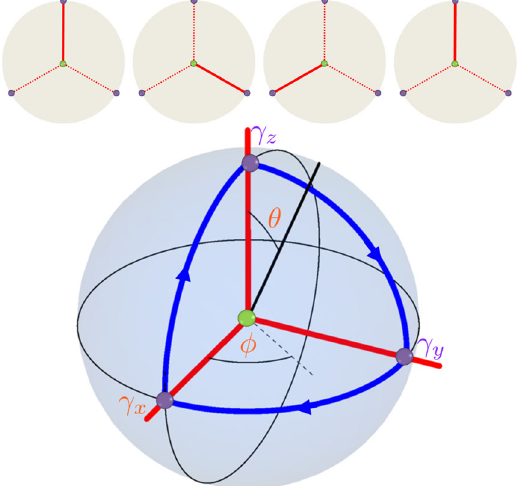
FIG. 2. A visualization of the exchange process as the turning ≫ Δ ; Δ arm of a clock. First, Δ , to indicate that the line z x y presenting the coupling between γ 0 and γ is bold. Then, z Δ ≫ Δ ≫ Δ ≫ Δ ; Δ ; Δ ; Δ , then Δ , and finally, Δ again, y x z x y z z x y so that the arm of the clock completes a full turn. This process can also be visualized as a line covering an octant on a unit sphere. The Berry phase difference of the two parity sectors accumulated in this process is equal to the covered solid angle, − π = 2 . We show in the text (see Appendix A) that this gives rise to a − π = 4 phase gate, meaning a phase ∓ π = 4 for each fusion channel. (The minus sign appears due to the clockwise orientation of the trajectory and the convention we chose.) Since we can make one of the coupling constants exponentially smaller than the other two, the trajectory in the parameter space is glued to the edges of the octant making the accumulated Berry phase difference equal to − π = 2 with exponential